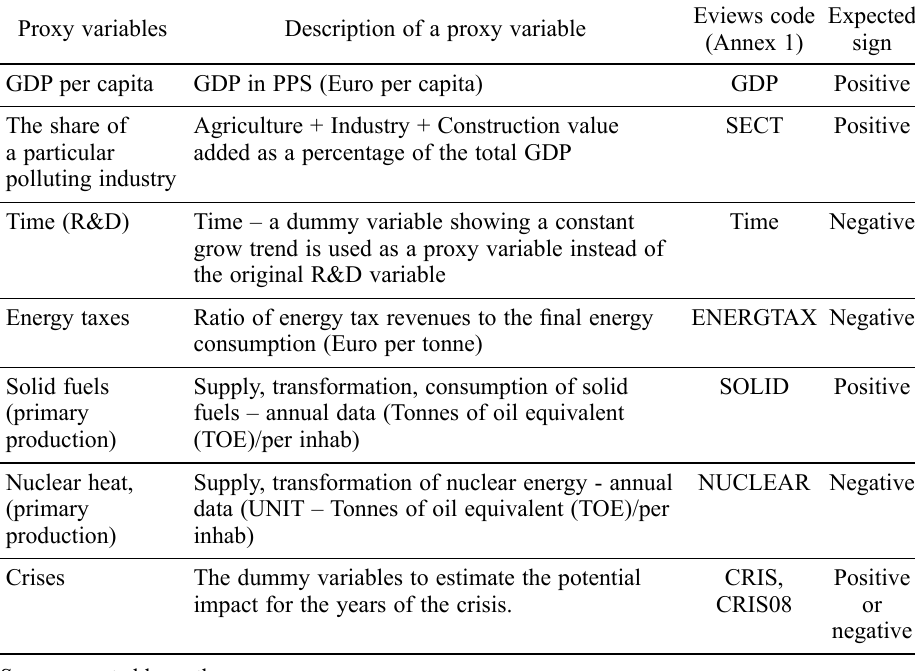
Table 1. Chosen proxy variables affecting